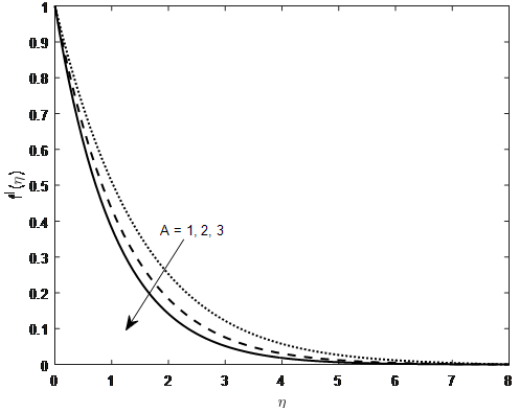
Figure 10: Velocity profiles for different values of unsteadiness parameter A